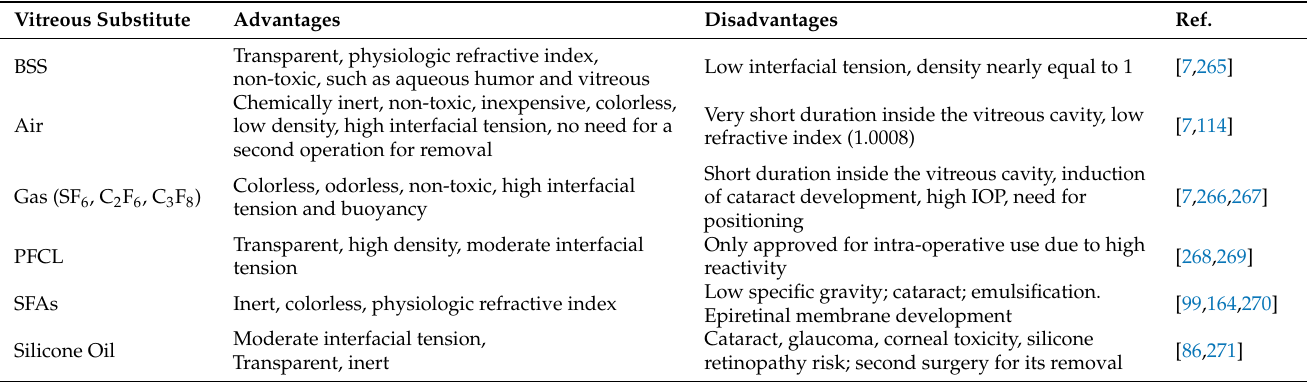
Table 3. Advantages and disadvantages of the vitreous substitutes available in the current clini- cal